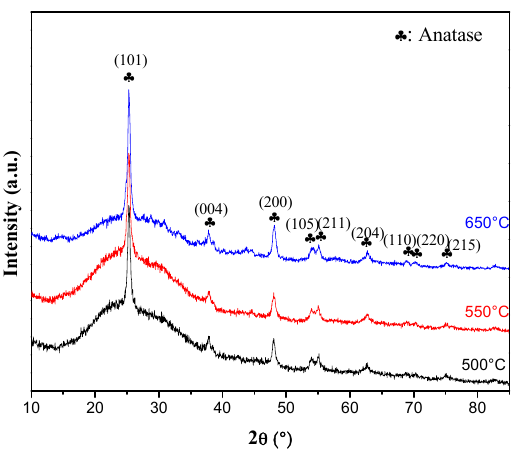
Figure 3. GXRD patterns of the 2% Y-N codoped TiO 2 thin films annealed at different temperature.